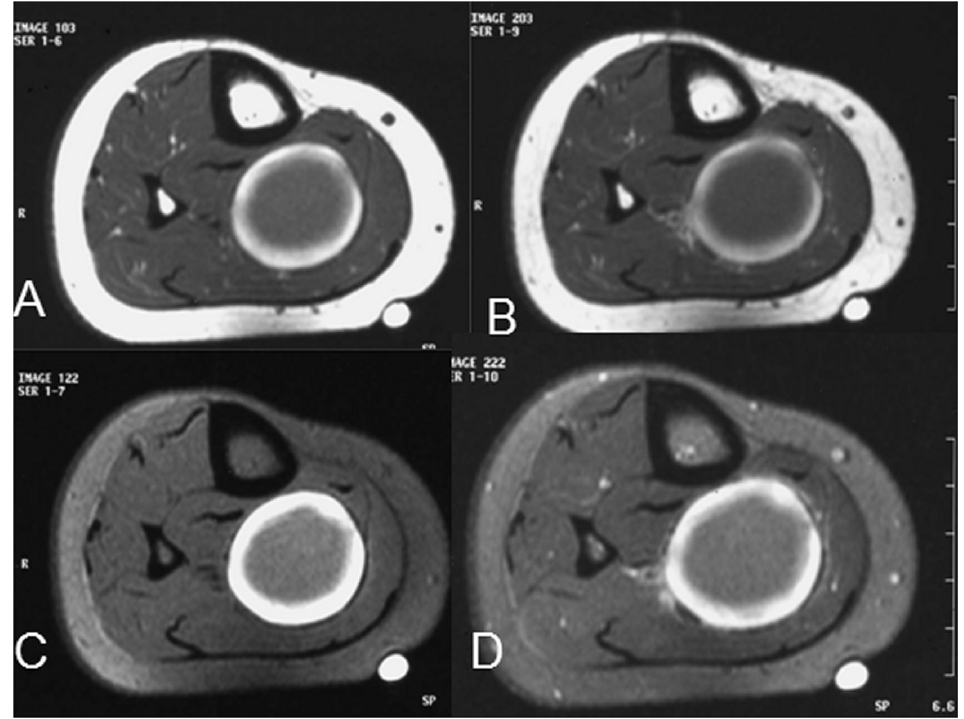
Figure 3 - A giant thrombosed venous aneurysm in the calf as viewed by axial MRI sections. A. T1-weighted before contrast injection. B. T1-weighted post contrast injection. C. T1-weighted and fat-saturated images before contrast injection. D. T1-weighted and fat-saturated images post contrast